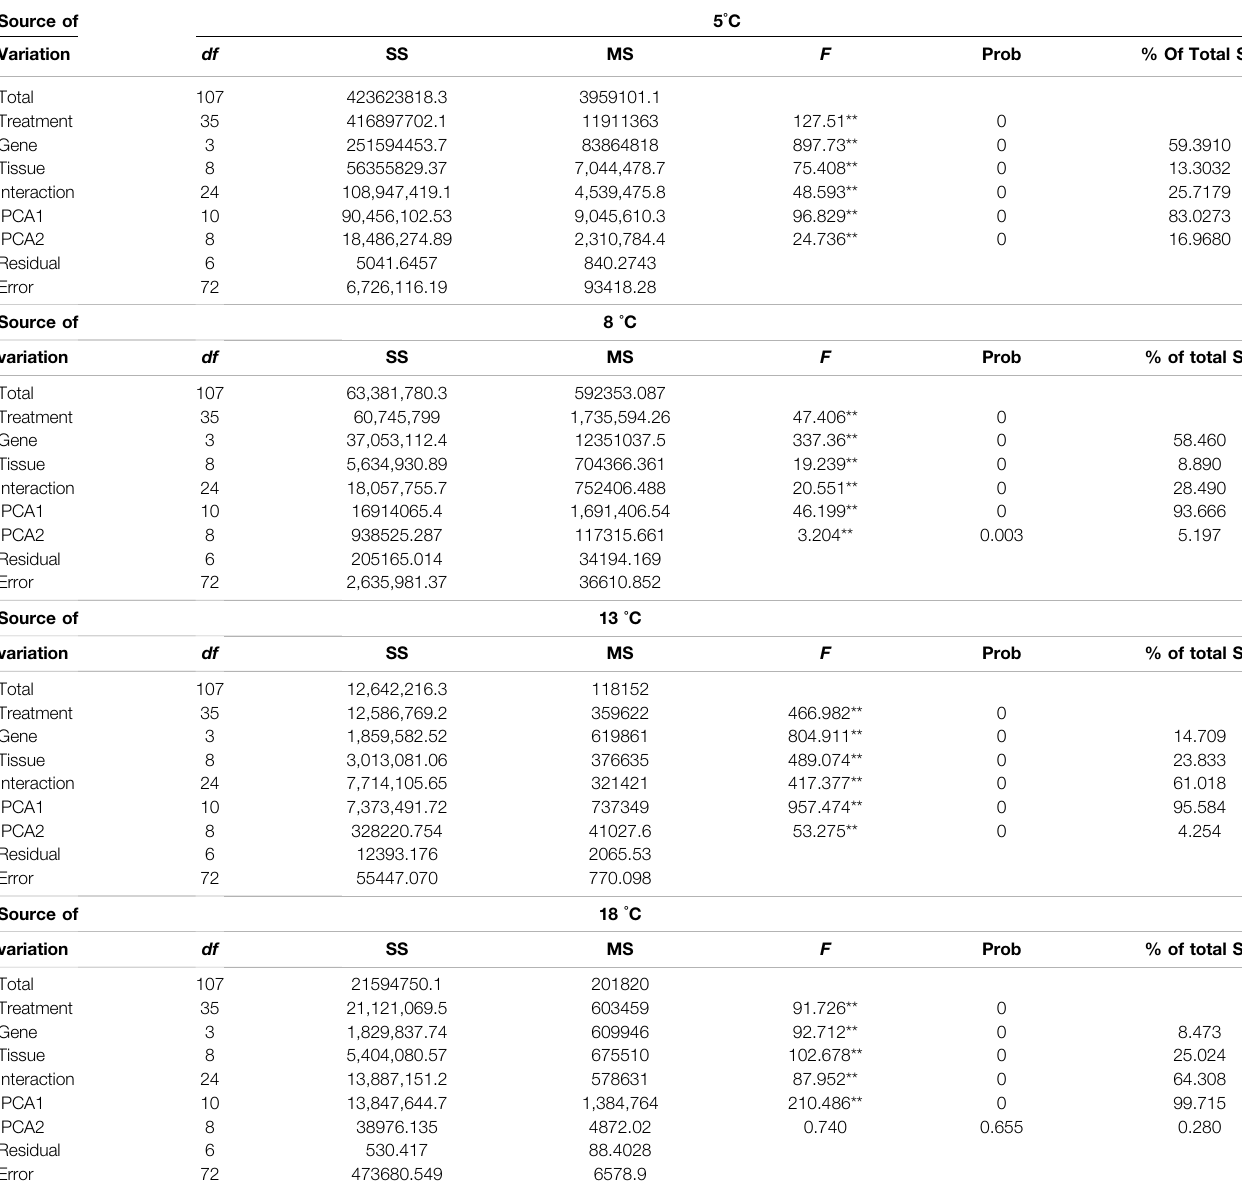
TABLE 4 | Results of AMMI analysis of expression of the four genes in different tissues from fi sh cultured at different temperatures. Source of 5 ° C Variation df SS MS F